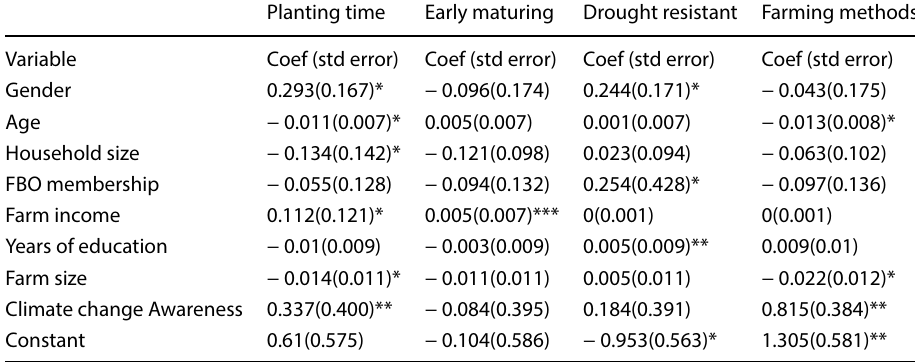
*, ** and *** represent 10%, 5% and 1% significance level, respectively. FBO: